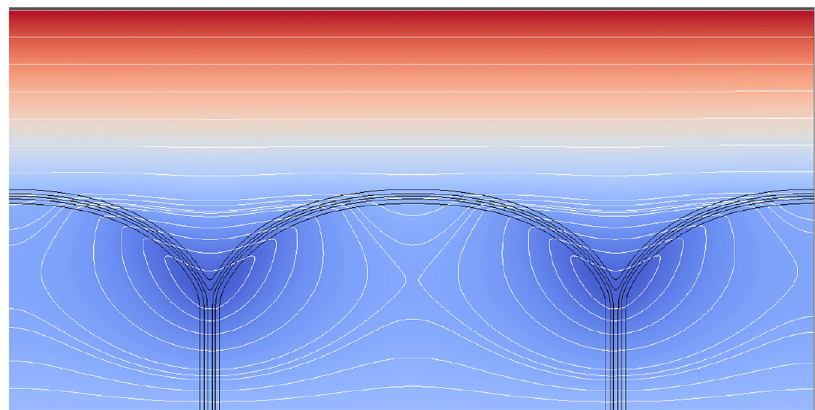
Fig. 7 Steady-state temperature fi eld (where red is warm, blue is cool) and its co-dependent phase- fi eld image. Isotherms (white lines) remain nearly horizontal in the liquid phase, where they lie well above the s / ℓ (black) isolines. Lower isotherms break into loops surrounding the triple junctions, which are locations where capillary-mediated cooling, i.e., heat absorption, is most intense, forming cooler "blue valleys" that surround the triple